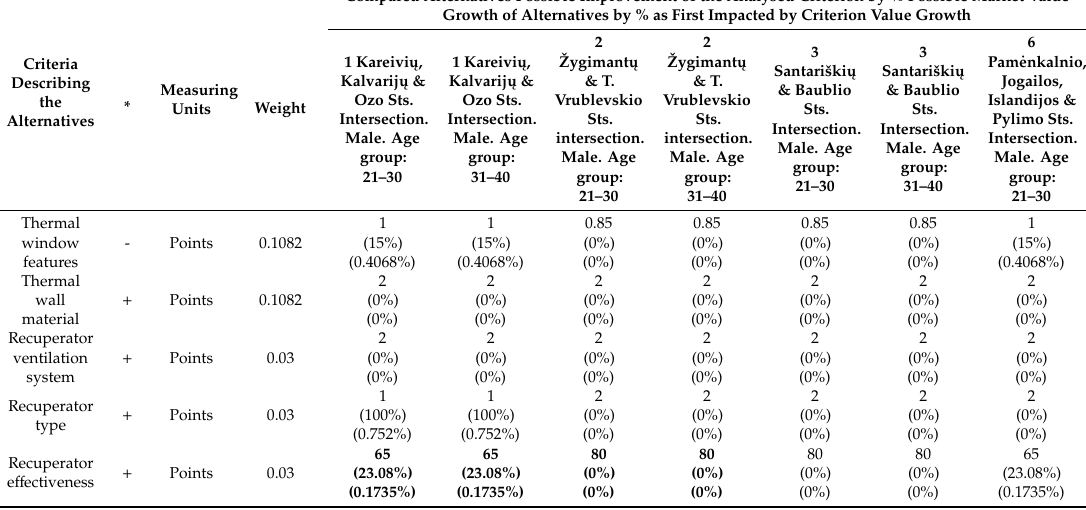
Table 6. A sample of digital recommendations on ways to improve the attractiveness of housing at the four sites in